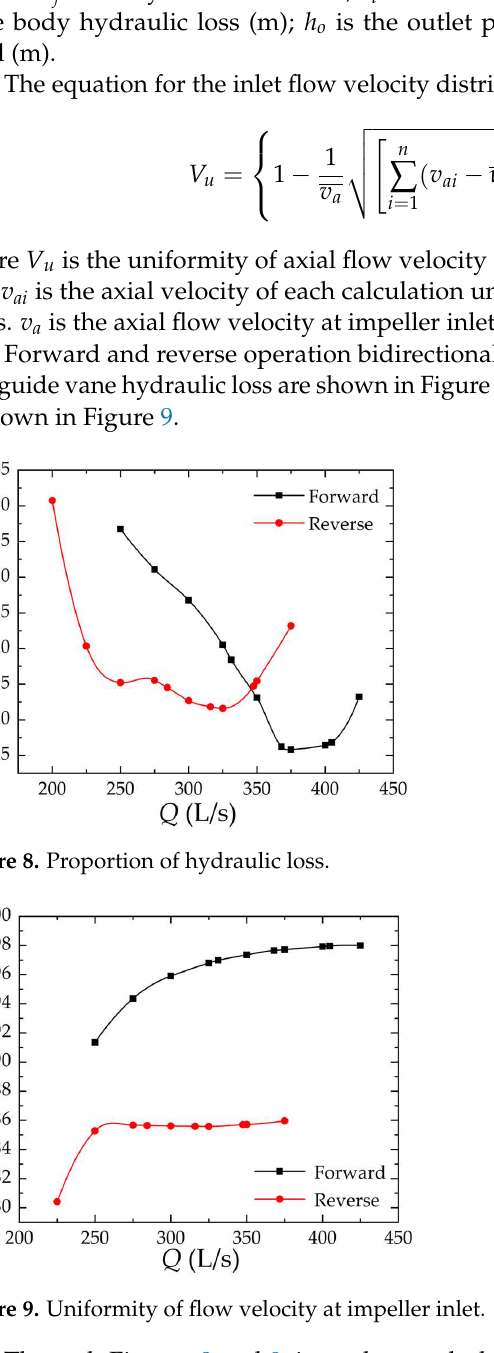
( b ) Reverse operation Figure 10. 0.9 Q d 3D streamline diagram.